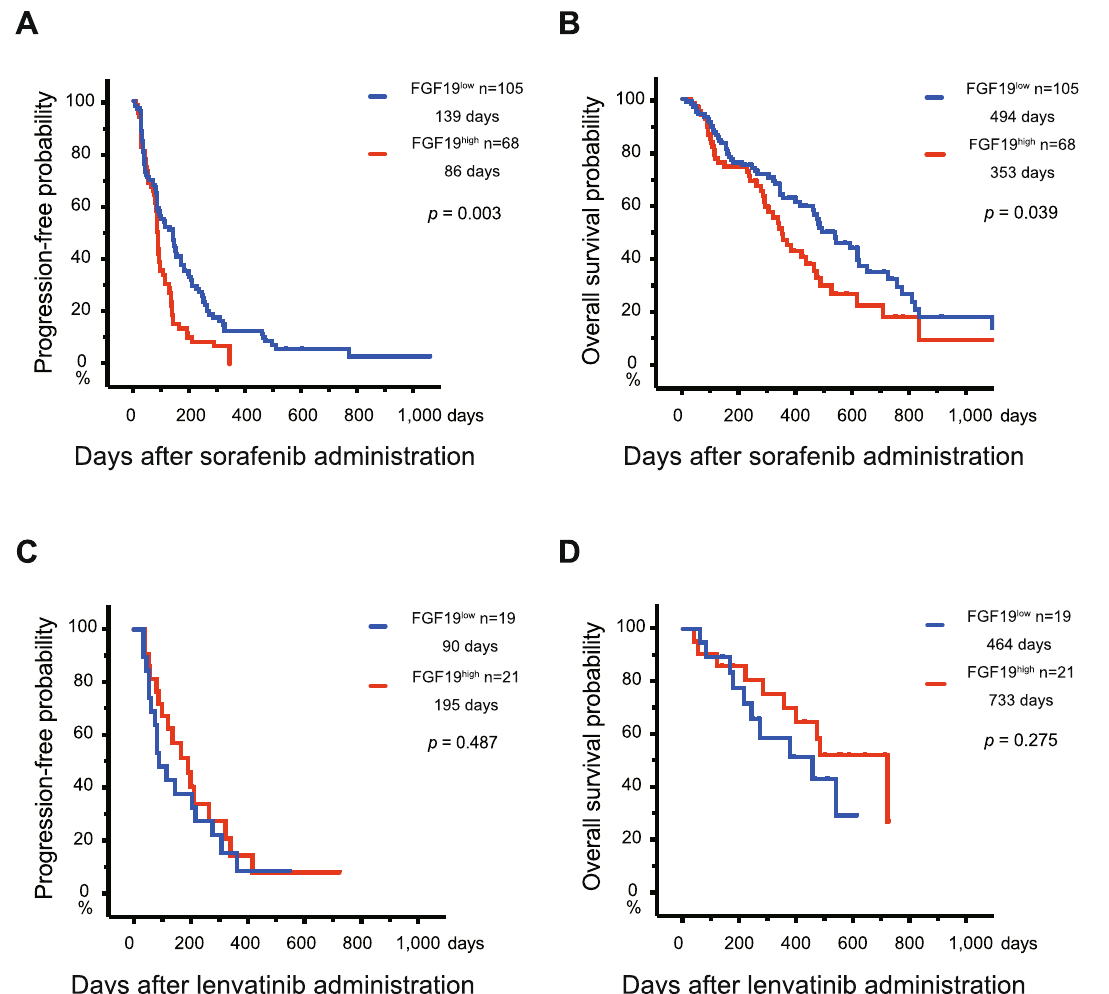
Figure 6. Prognosis of HCC patients treated using MKIs based on serum FGF19 levels before treatment. ( A , B ) Progression-free survival (PFS) ( A ) and overall survival (OS) ( B ) of patients treated using sorafenib based on serum FGF19 levels. ( C , D ) PFS ( C ) and OS ( D ) of patients treated using lenvatinib based on serum FGF19